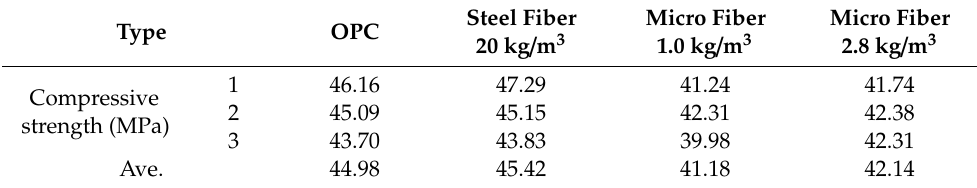
Table 5. The results of compressive strength test.